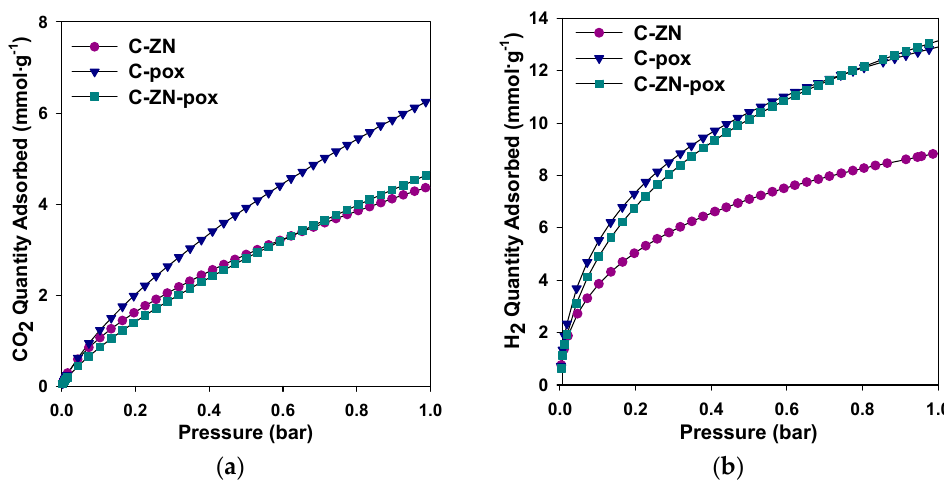
Figure 4. ( a ) CO 2 adsorption isotherms measured for the selected carbons at 0 °C; ( b ) H 2 adsorption isotherms measured for the selected carbons at − 196 °C. Table 3. Carbon dioxide and hydrogen uptakes for the selected carbon samples.